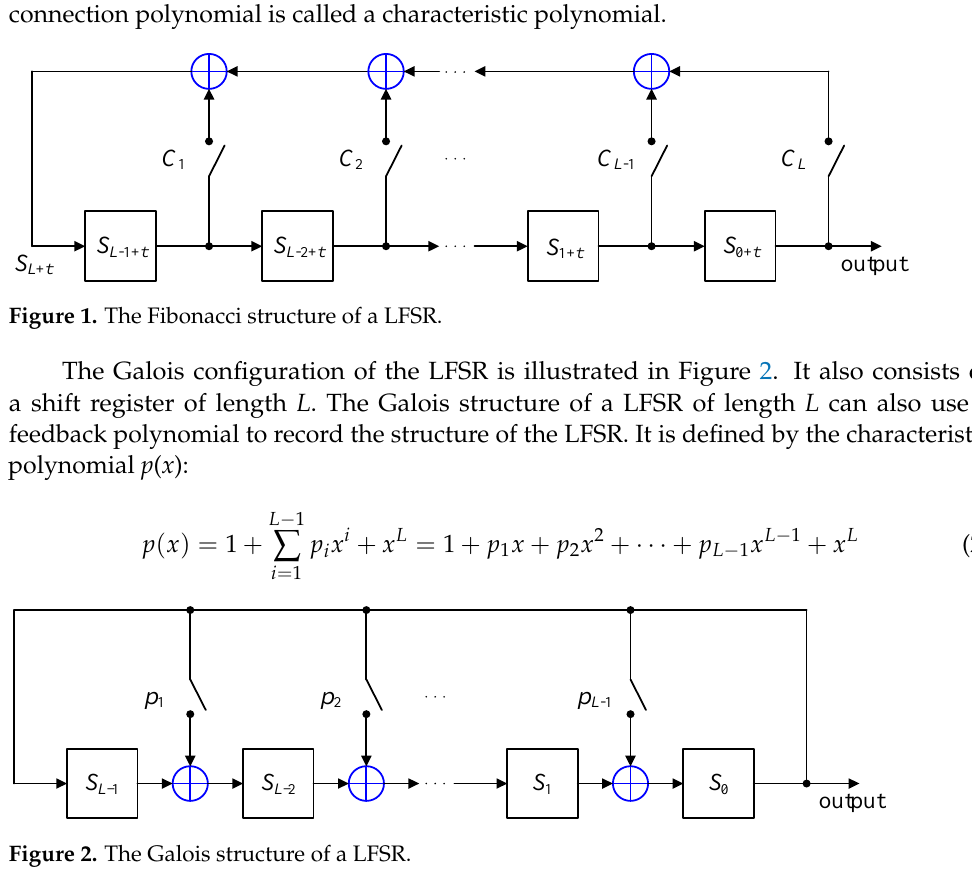
keystream R 1 Figure 3. The diagram of A5/1 stream cipher. To reduce the weaknesses of A5/1, some solutions have been proposed in the literature. Erguler and Anarim, in 2005, proposed an A5/2 algorithm that consists of four registers and modified the clocking control mechanism to promote its security strength [20]. In 2006, Erguler and Erguler proposed a LFSR-based CCDM (Clock-Controlled with Dual Mode) stream cipher with a dual operating mode [15]. It is a novel clock-controlled stream cipher with Dual Mode, which is based on irregular clocking and operates with two different modes. The CCDM-Mode I merges eight 4 × 16 S-boxes of DES [21] for the keystream generation, and the CCDM-Mode II operates with a mutual clock-control mechanism. Zakaria and et al., in 2011, presented two modifications of A5/1 [22]. One is the changing of the original primitive polynomials of LFSR in A5/1. The second modification added two LFSRs and proposed five LFSRs in total. The scheme passed the